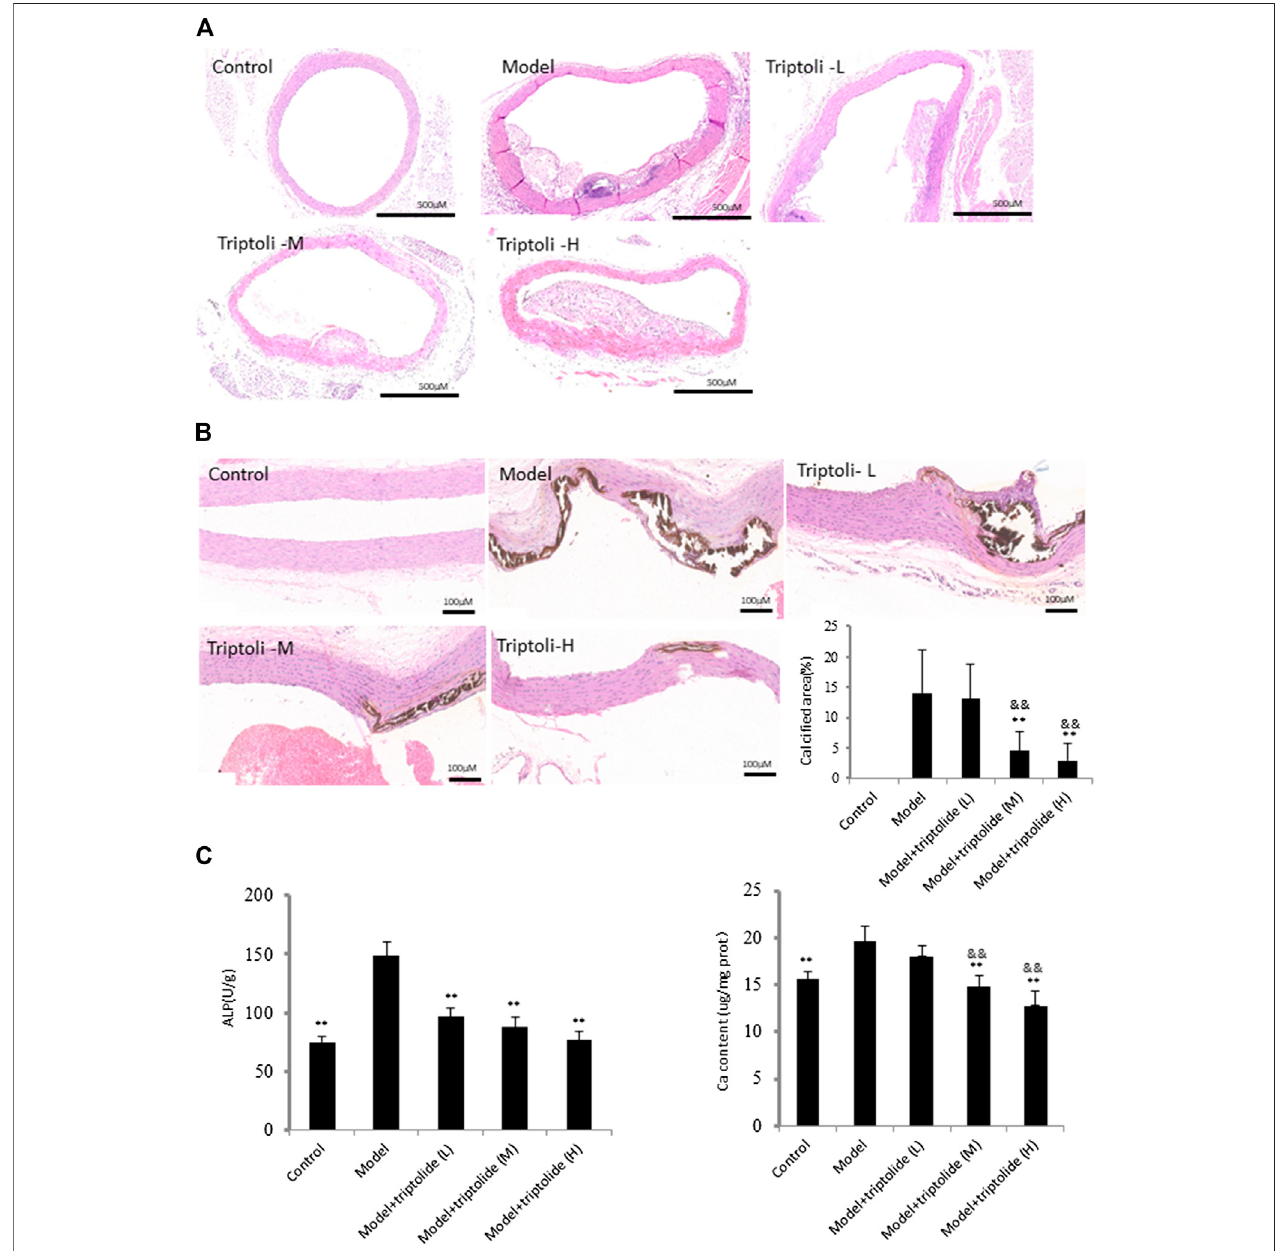
FIGURE 1 | TP attenuates vascular calci fi cation induced by VDN (A) HE staining shows thickened vessel walls, disordered elastic fi bers and widespread calci fi cation in aortas of rats (B) Left: von Kossa staining shows increased calcium deposition in aortas of rats; right: bar graphs show quantitative evaluation of the von Kossa calcium area (n (cid:2) 10) (C) Bar graphs show quantitative evaluation of ALP and calcium content (n (cid:2) 10). ** p < 0.01 compared with model group, && p < 0.01 compared with model + TP-L group.